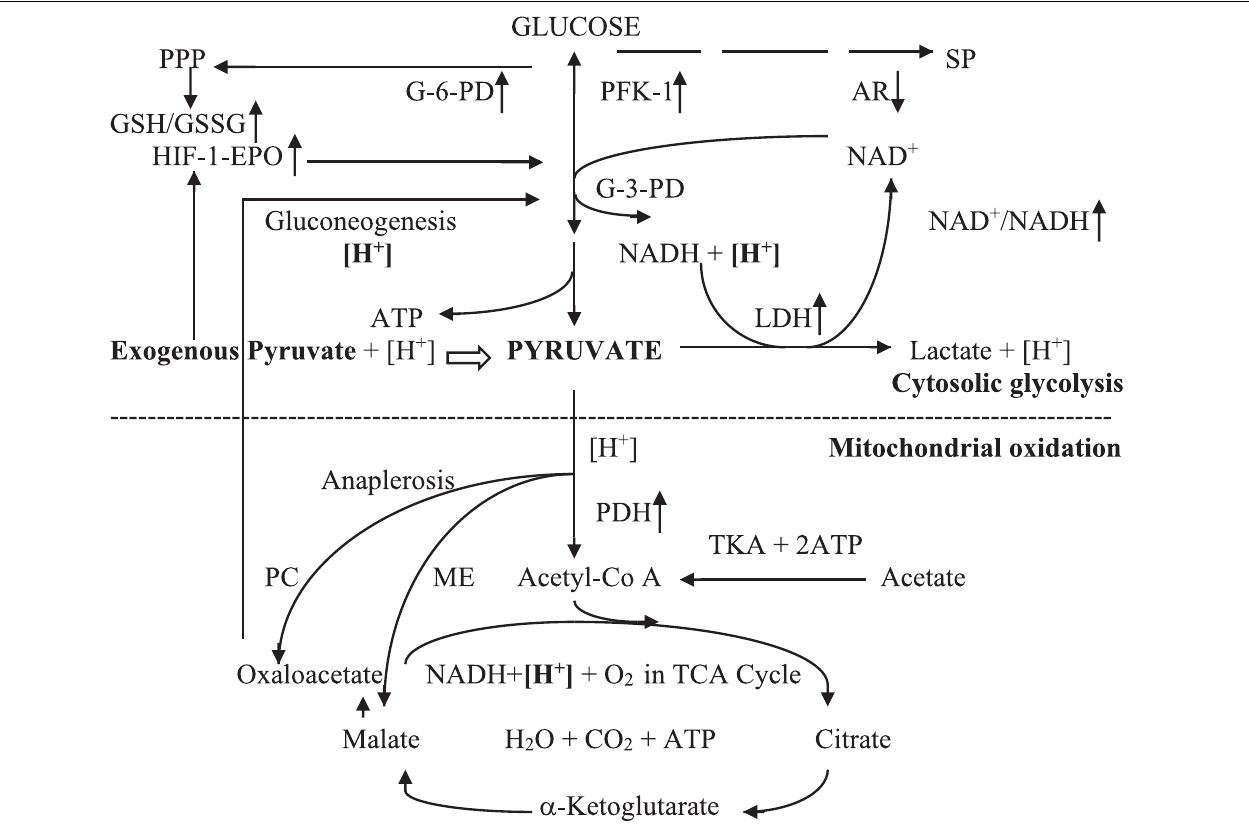
FIGURE 1 | Exogenous pyruvate metabolism in cellular hypoxia. Exogenous pyruvate enters cell plasma with [H + ]. The pyruvate or glycolytic pyruvate with [H + ] spontaneously reduces to lactate with LDH free of energy in anoxia, leading to [ H + ] consumption and increment of the NAD + /NADH ratio that promotes the glycolytic pathway at glyceraldehyde-3-phosphate dehydrogenase. Exogenous pyruvate also facilitates glycolysis by stimulating the HIF-1 α -EPO signal pathway, increasing G-6PD activity, thereby preserving the PPP pathway and GSH/GSSG ratio. It inhibits AR activity in the sorbitol pathway likely by competing